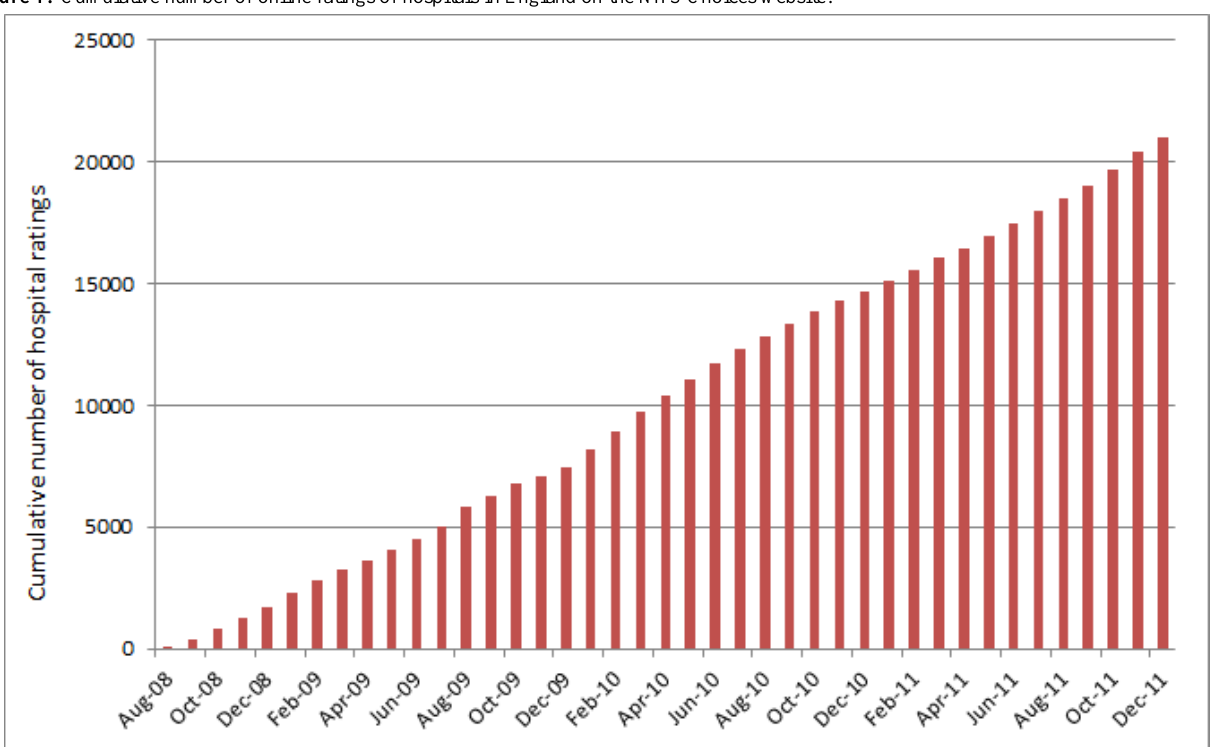
Figure 1. Cumulative number of online ratings of hospitals in England on the NHS Choices